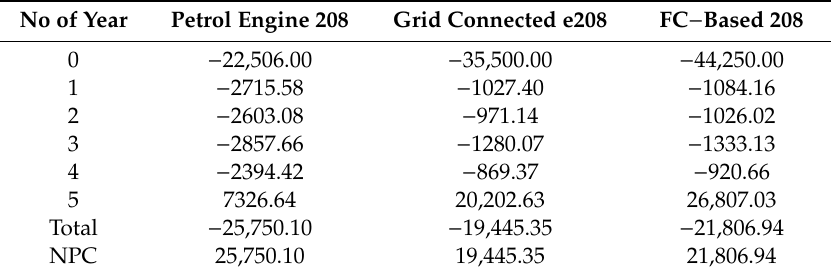
Table 4. Discounted cash flows and Net Present Cost